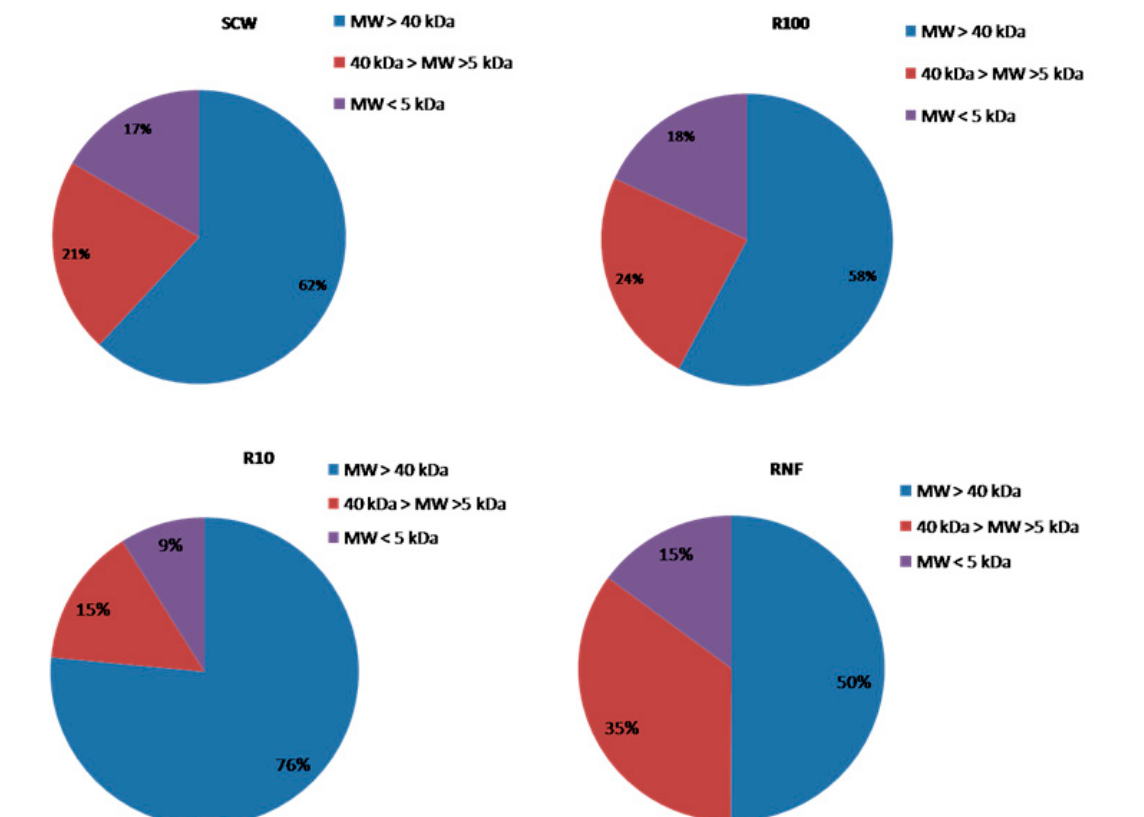
Figure 1. Molecular weight distribution of proteins found in SCW and ultrafiltration and nanofiltration retentates.